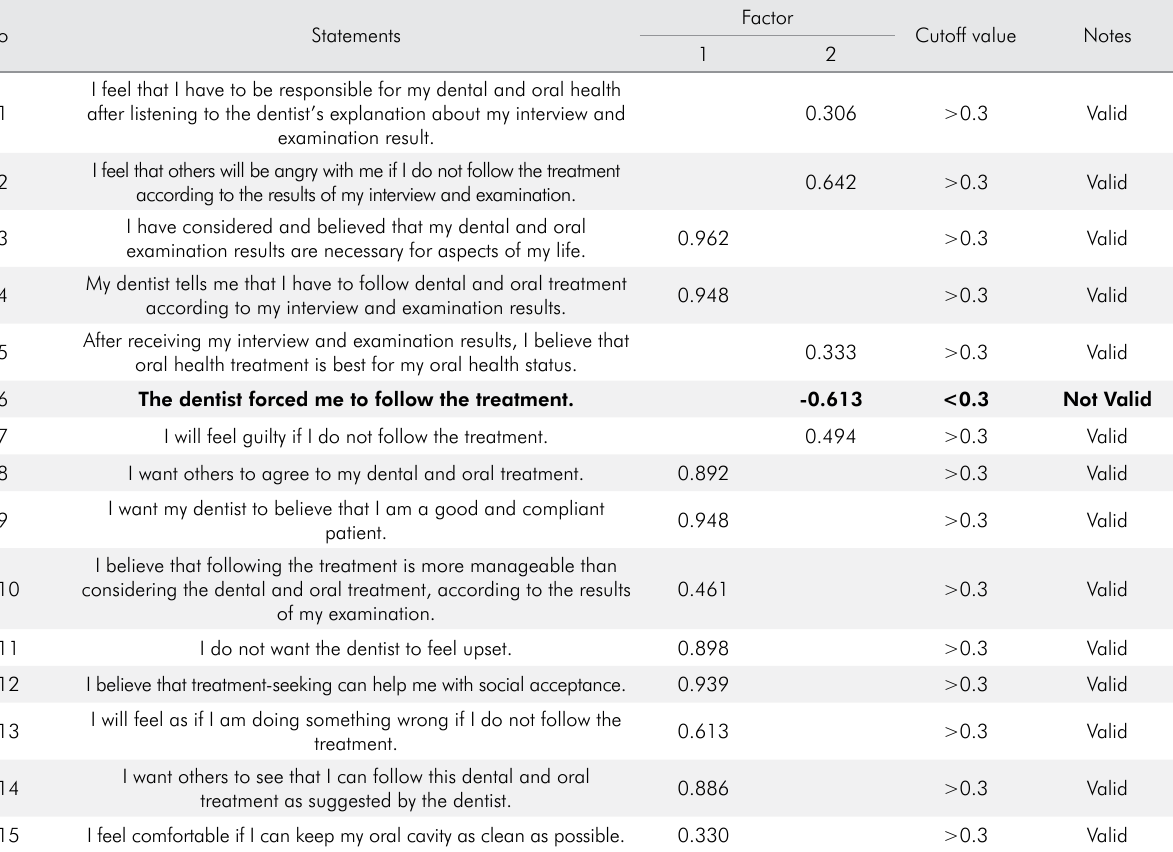
Table 5. Results of the loading factor validity test based on the exploratory factor analysis (EFA) of the cross-cultural adaptation of the modified DTMS